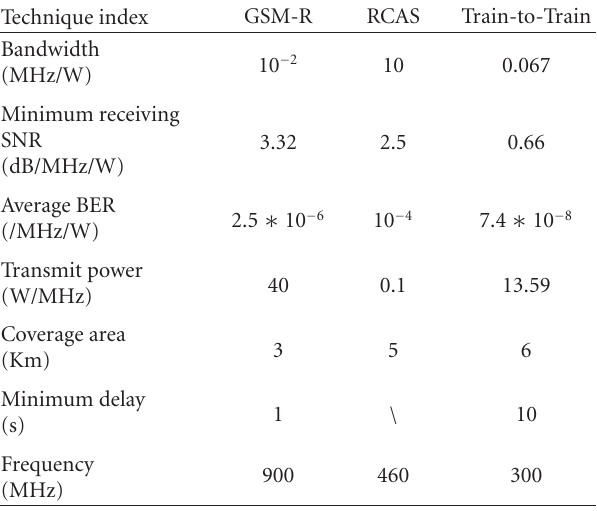
Table 2: Comparison of technique index of the GSM-R, RCAS, and train-to-train in physical